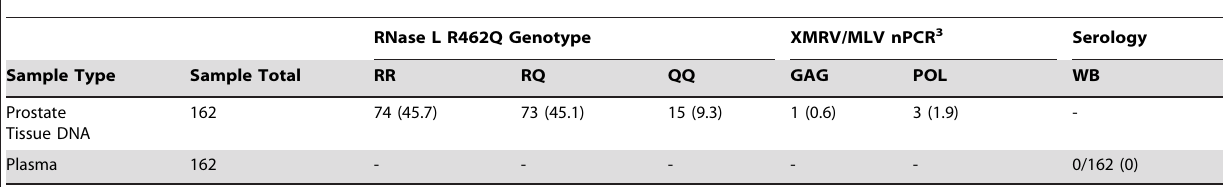
Table 1. XMRV/MLV infection is rare in prostate cancer 1,2 .